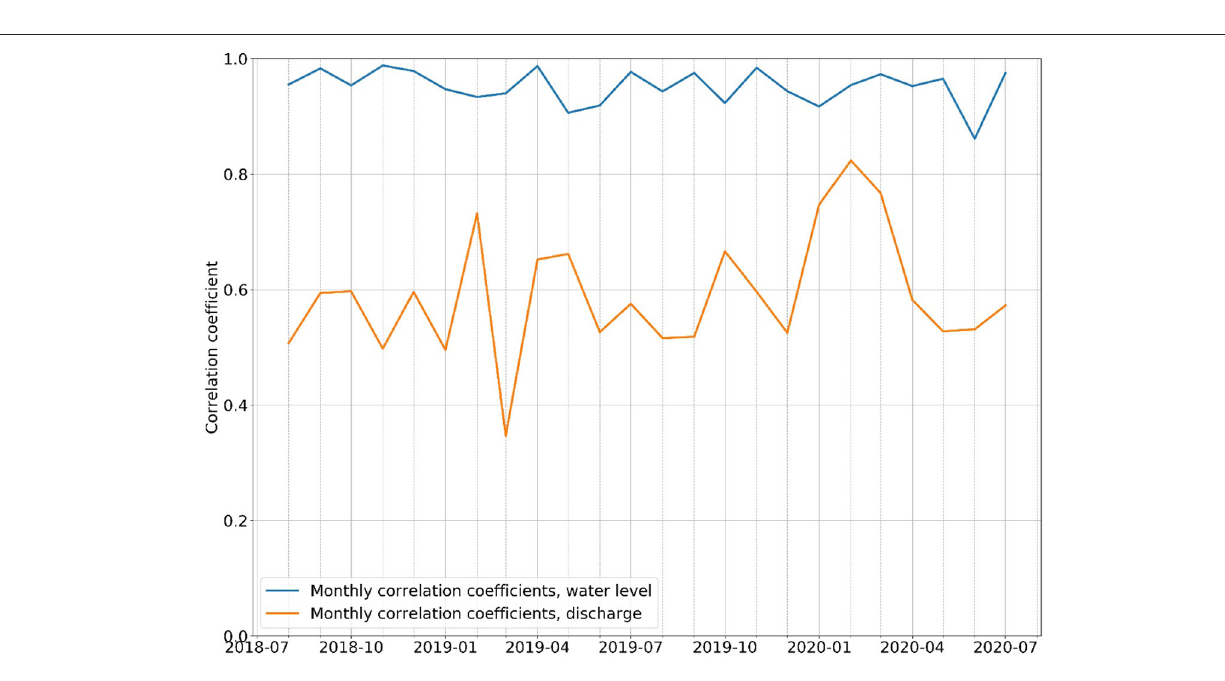
FIGURE 10 | Monthly correlation coefficients between calculated and measured water level and discharge in the Trade